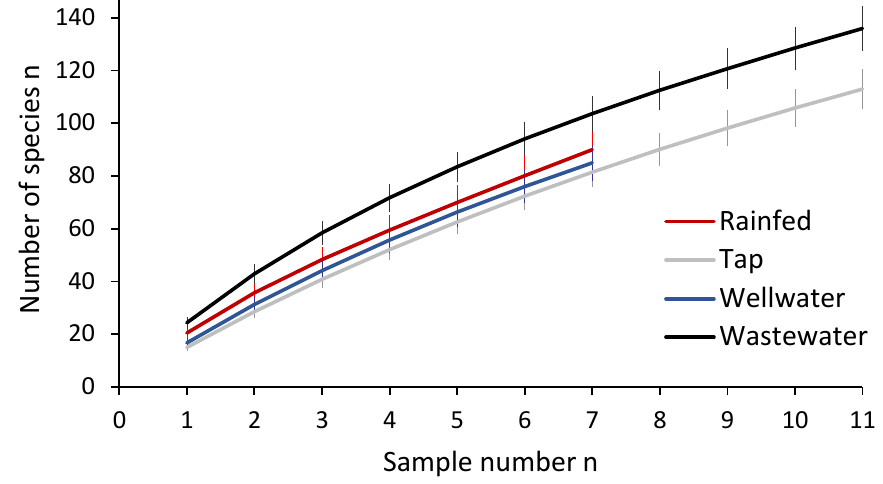
Figure 3. Arthropod species accumulation curves (Mao Tao estimator ± standard deviation) of vegetable fields under different irrigation sources (four urban and peri-urban agriculture (UPA) locations) of Tamale, Northern Region, Ghana in August 2016.